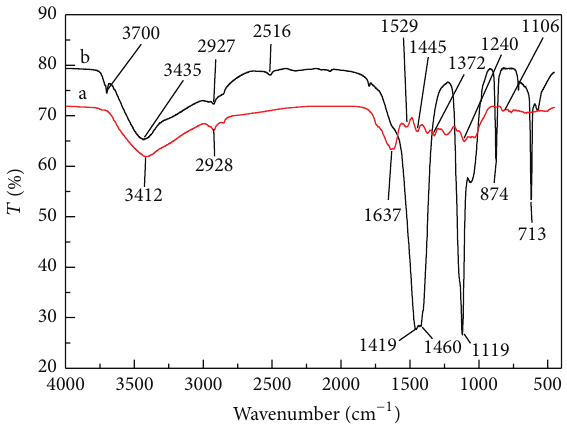
Figure2:FTIRspectraof(a) C.polygonoides and(b) C.polygonoides ash.